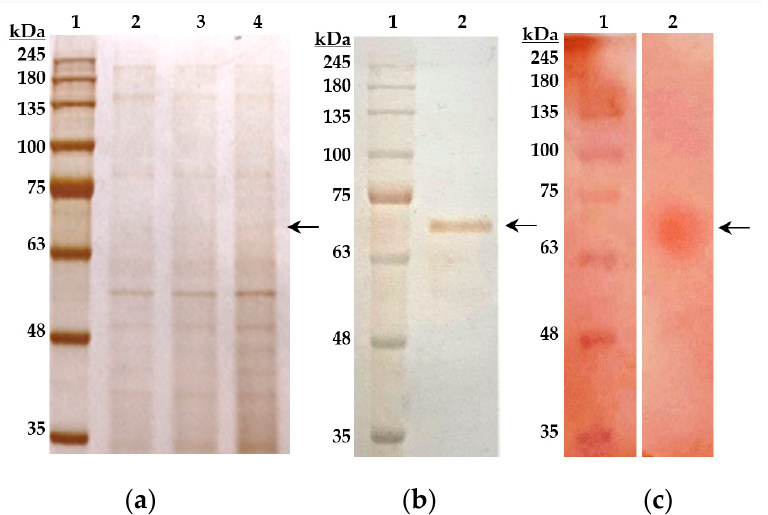
Figure 3. Sialidase of O. paurometabola O129 (marked by arrow), shown by SDS-PAGE in a 10% sep- Figure 3.